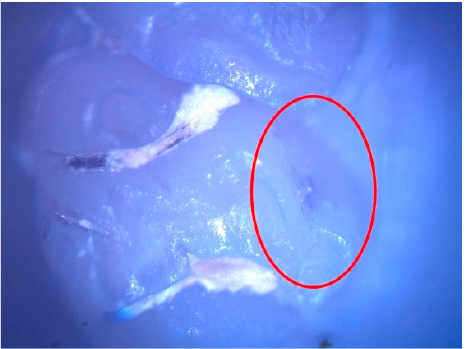
Figure 3. Hypoplasia lesion (surrounded by the red oval) on the palatal surface of 27.